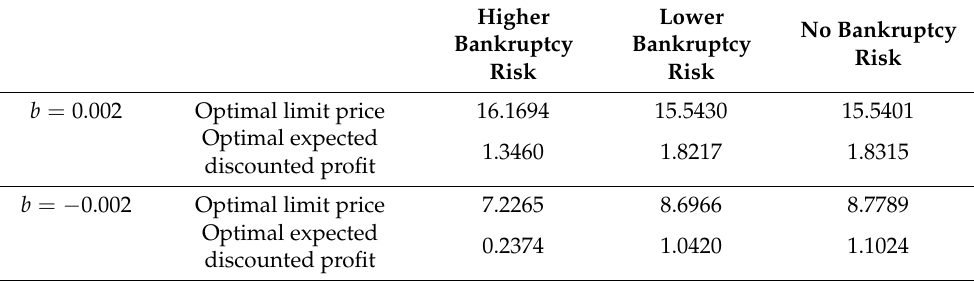
Table 1. The optimal limit prices and their optimal expected discounted profits of the sell limit